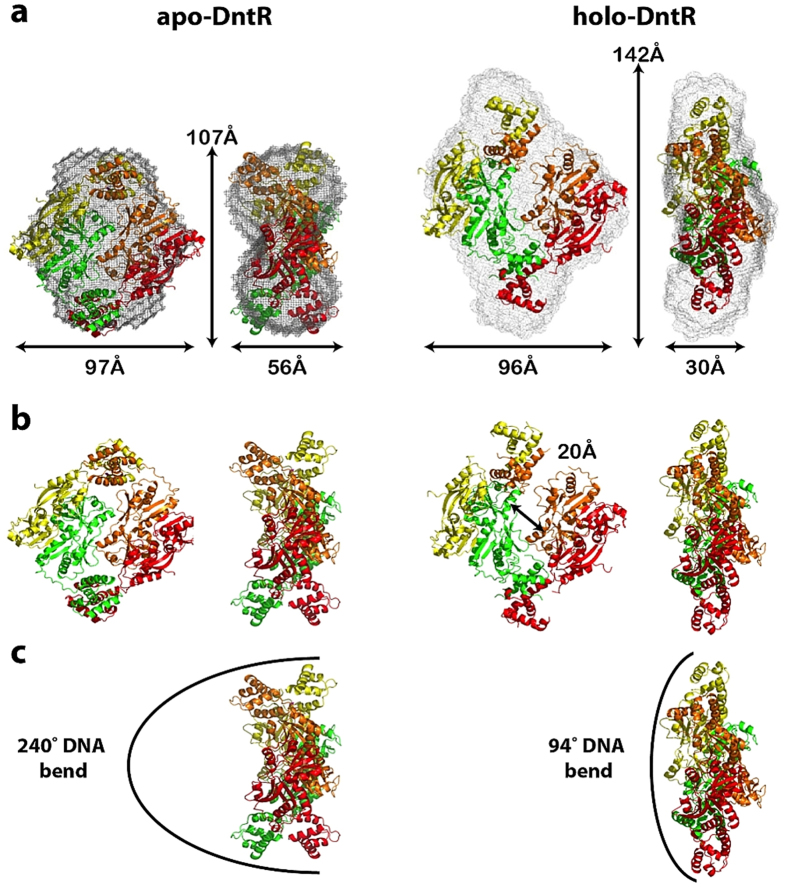
The solution conformations of apo- (left) and holo-DntR
(right).(a) Orthogonal views of the ab initio molecular envelopes (grey
mesh) and the SASREF-obtained models of the solution conformations of
apo-DntR (P22 symmetry imposed on the molecular envelope) and
holo-DntR. The dimensions of the SAXS-obtained ab initio
envelopes are shown. (b) Orthogonal views of the SASREF-derived
solution conformations of apo-DntR and holo-DntR. The
transition from compact (apo-) to expanded (holo-)
homotetrameric configurations involves an ‘opening’,
shown by the black arrow, by ~20Å of the central
tetrameric RD core. (c) Side views of the SAXS-obtained solution
conformations of apo- and holo-DntR showing the likely bend of
bound promoter region DNA.